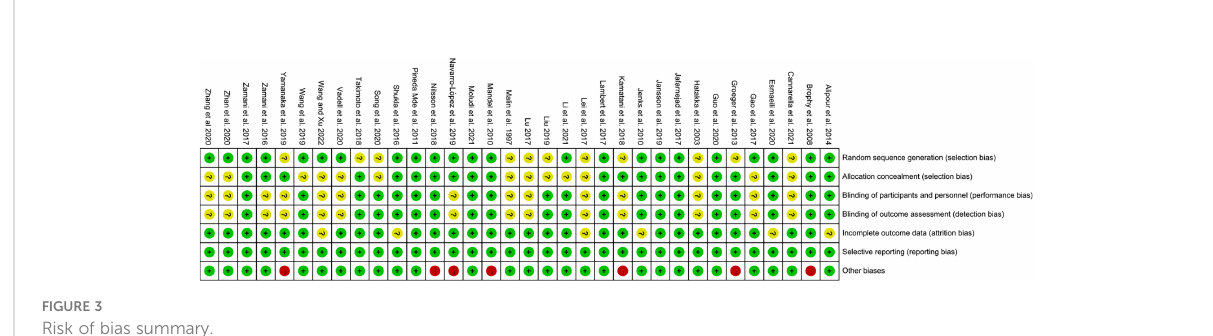
FIGURE 3 Risk of bias